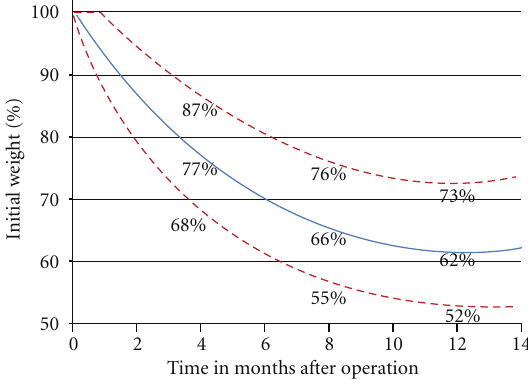
Figure 3: Regression model describing time after operation versus percent initial weight. n = 1551. All patient data points up to 500 days after operation were used to calculate the above